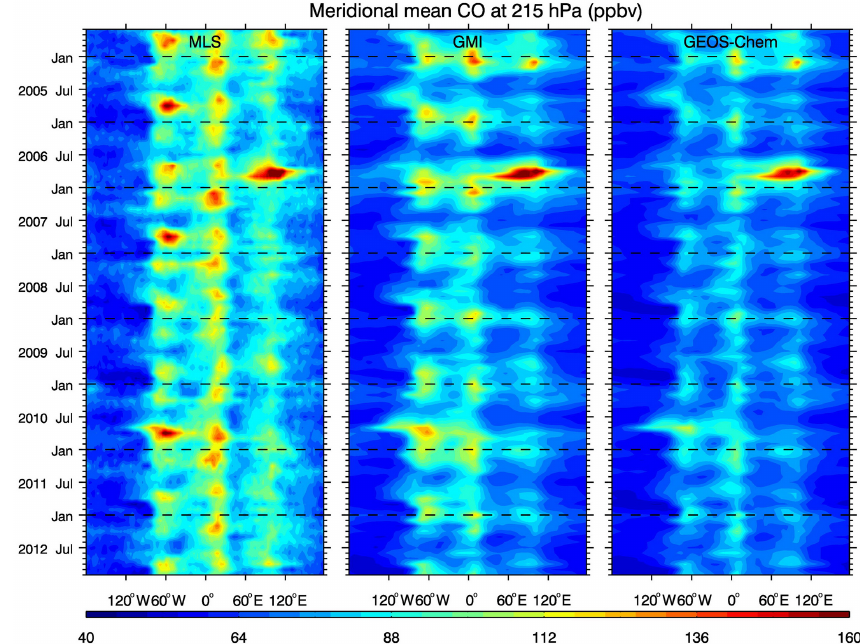
Figure 6. As in Fig. 5, but for CO mixing ratio at 100hPa.